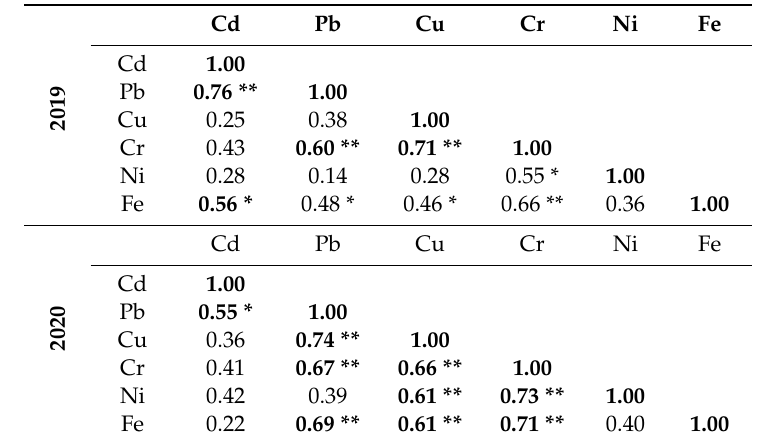
Table 3. Spearman correlation coe ffi cient between element content in mosses collected in Moscow region in 2019 and